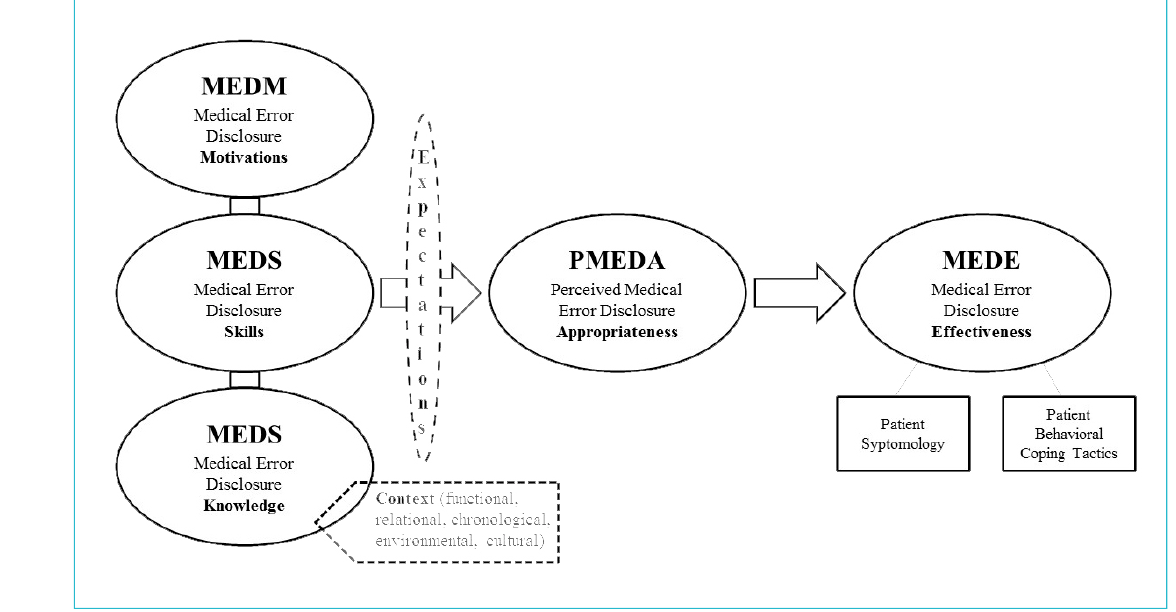
Figure 2: The new medical error disclosure competence (MEDC)